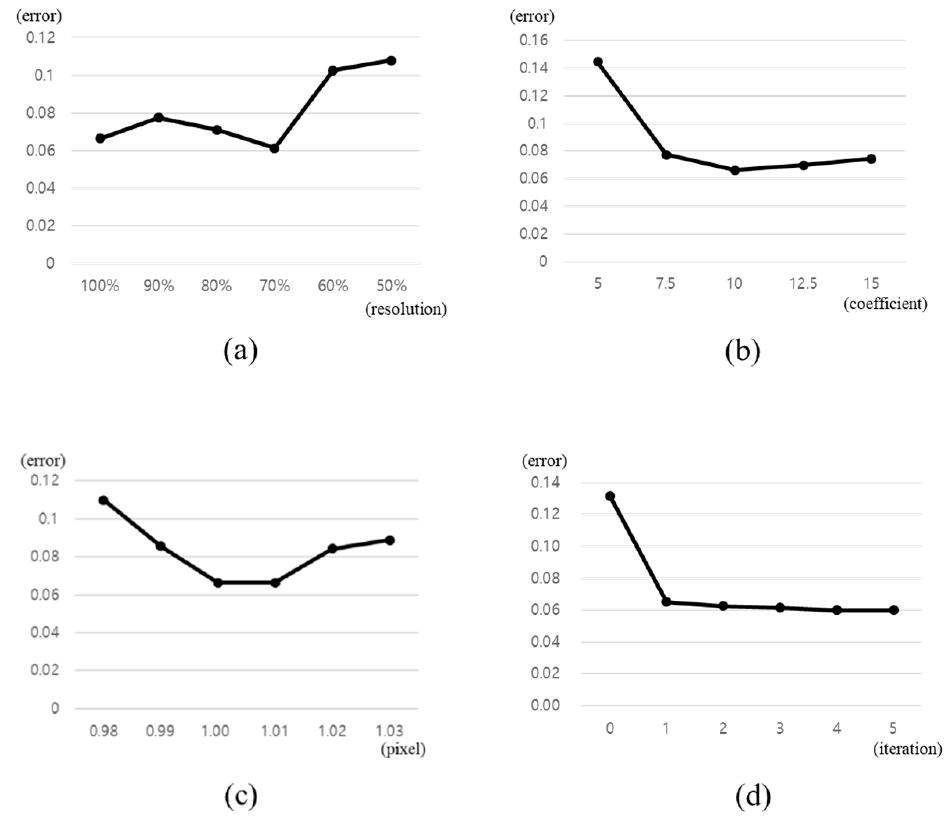
Figure 10. The result of the synthetic data test. ( a ) Resolution variation; ( b ) SIFT coefficient variation; ( c ) point-line distance threshold variation; ( d ) classification iteration variation.